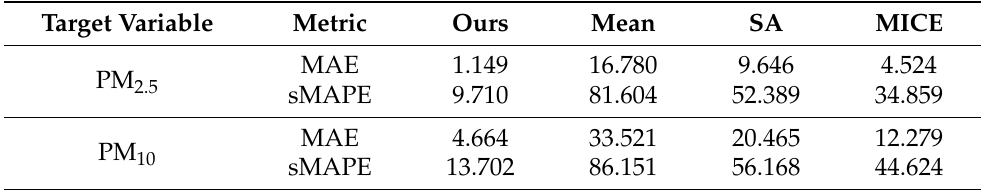
Table 3. Imputation performances of proposed method and other imputation methods on the Dangjin- si dataset. The proposed method shows the best imputation